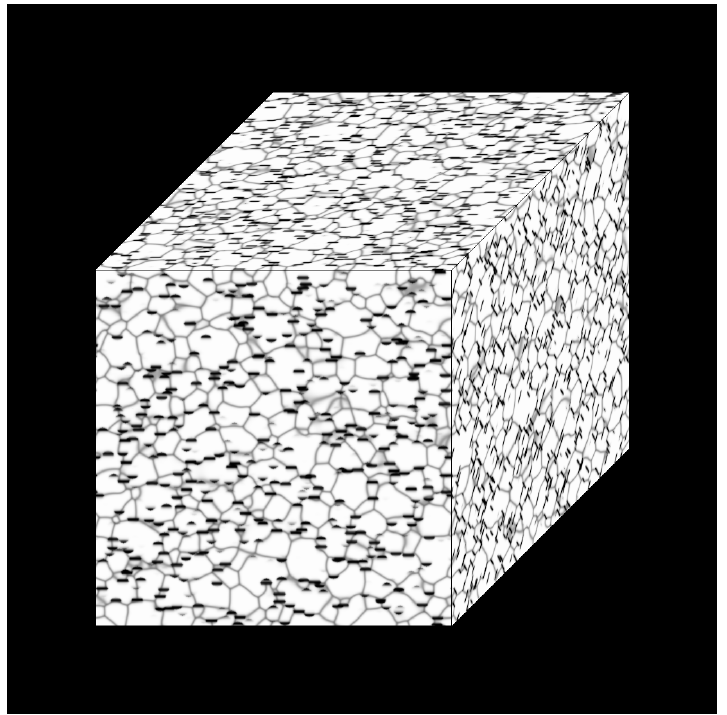
Figure 3. Grain structure with 3 vol% volume fraction at 14,000 ∆ t . The hydrides are aligned along two directions (two crystallographic variants) and the portions of each variant are equal. The system contains 3897 grains and average grain radius is 14.953. The volume of every hydride is